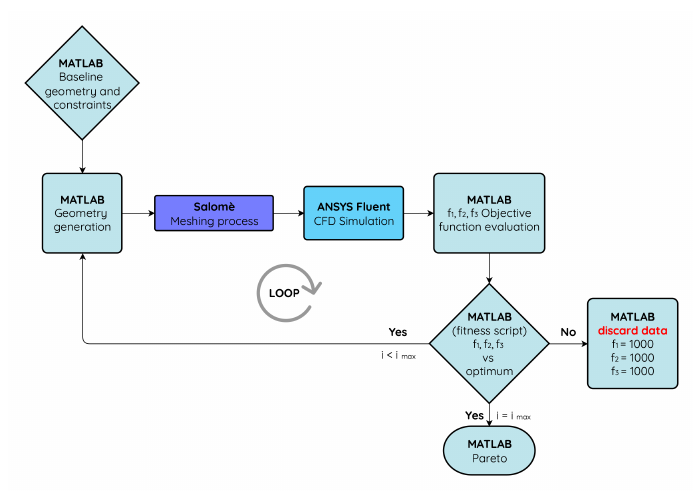
Figure 8. Schematic of the optimization